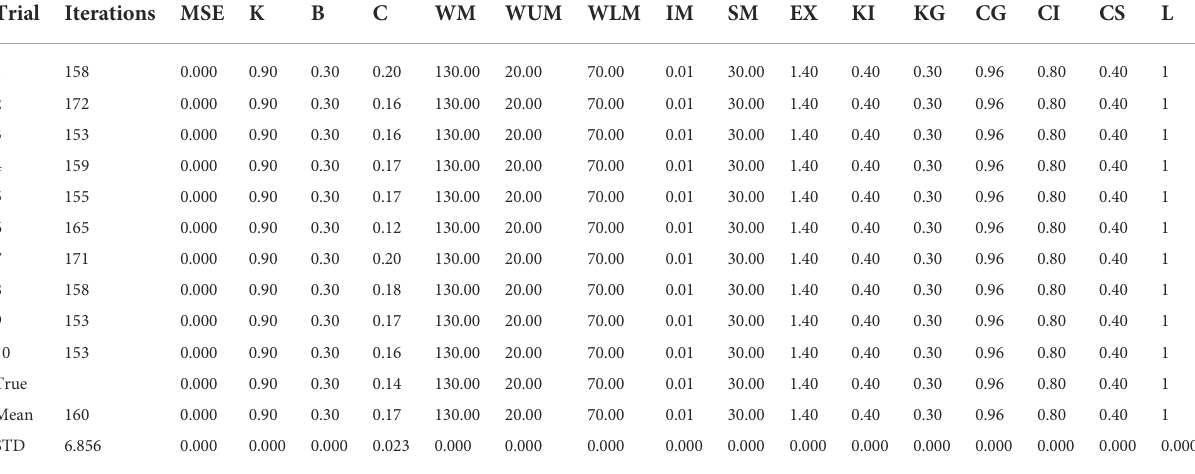
TABLE 5 Parameter calibration results using synthetic